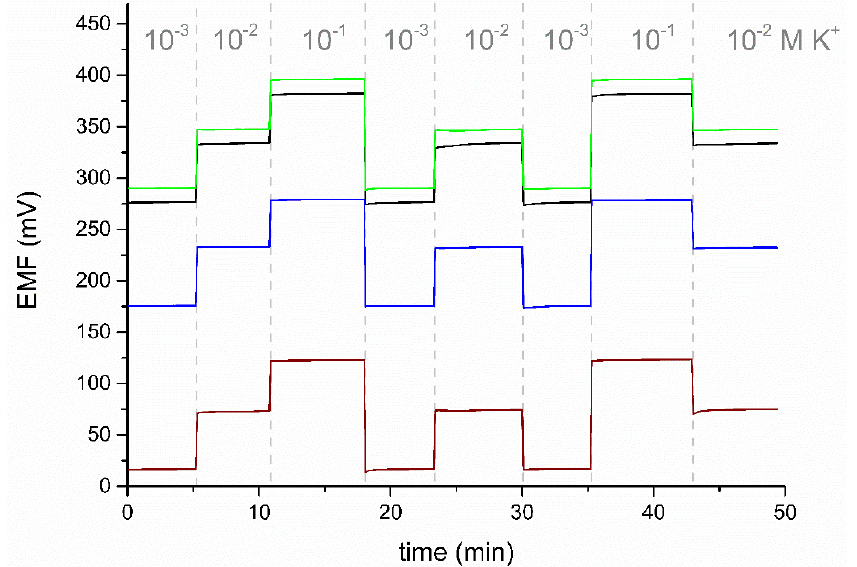
Figure 5. The reversibility test of electrodes GC/eCNF+POT/K + -ISM (black), GC/eCNF-Co+POT/K + -ISM (green), and GC/eCNF/CNT-NiCo+POT/K + -ISM (blue), and the coated disc electrode (wine), recorded in KCl solutions.